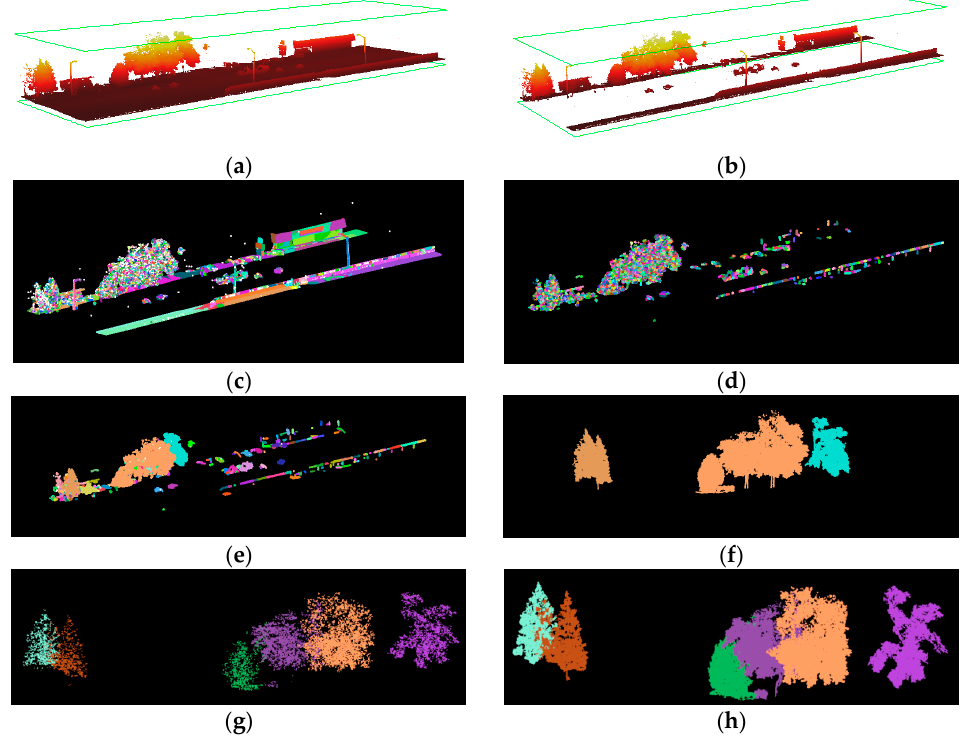
Figure 4. Demonstrating the process of individual tree segmentation: ( a ) the original Terrestrial LiDAR tile; ( b ) ground removal; ( c ) surface growing; ( d ) planar removal; ( e ) connect components; ( f ) tree detection; ( g ) trunk and branch building for individual tree segmentation; and ( h ) allocating the rest of the points.